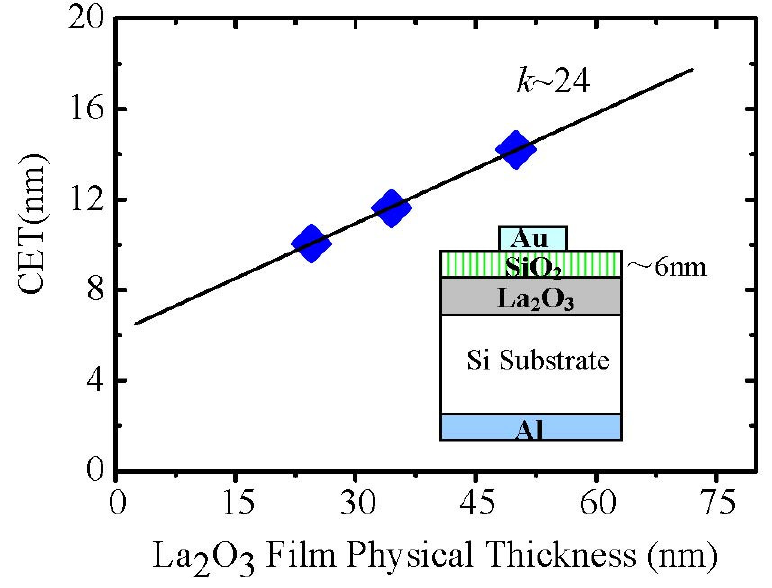
Figure 4. The relationship of CET to the La Au/SiO /La O /Si/Al MIS 2 2 3